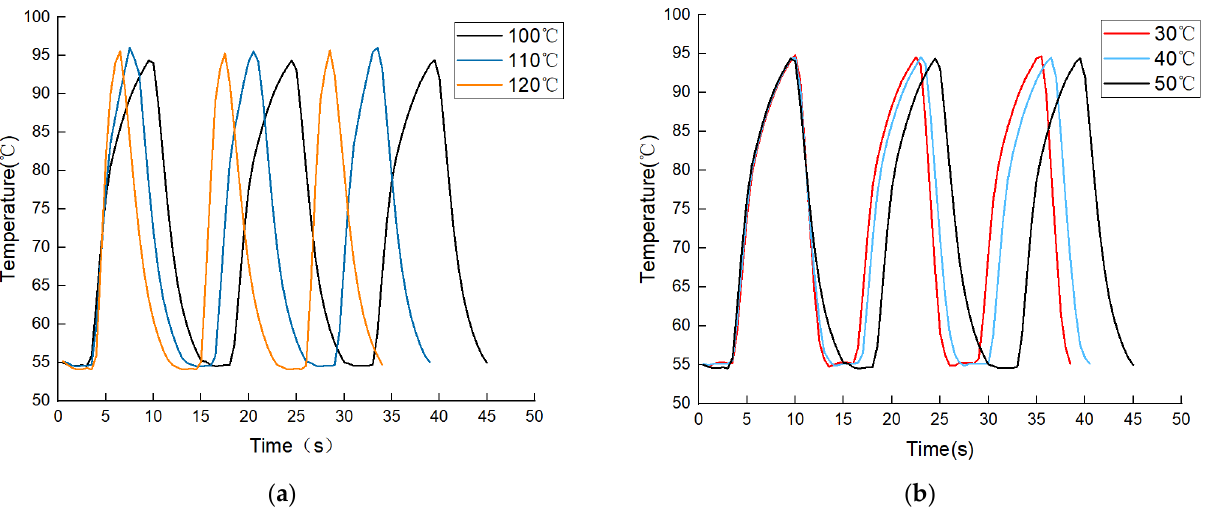
Figure 8. Temperature variation in three PCR cycles of the solution at different temperature over- shoots for TZ Ⅲ and TZ I: ( a ) 3 PCR cycles of TZ Ⅲ at 100 °C, 110 °C, and 120 °C. ( b ) Three PCR cycles of TZ I at 50 °C, 40 °C, and 30 °C. Table 3. Thermal performance of solution at different temperature overshoots in TZ Ⅲ and TZ I.